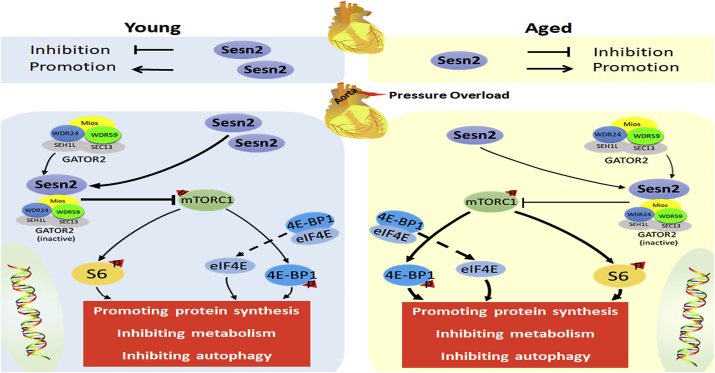
Molecular pathways involved in Sesn2 signaling. During pressure overload, Sesn2 expression increases. Elevated Sesn2 inactivates GATOR2 by binding interactions with its three subunits (MIOS, WDR24, and WDR59), thereby reducing the phosphorylation and activity of mTORC1. The mTORC1-induced phosphorylation of S6 and 4EBP1 decreases.